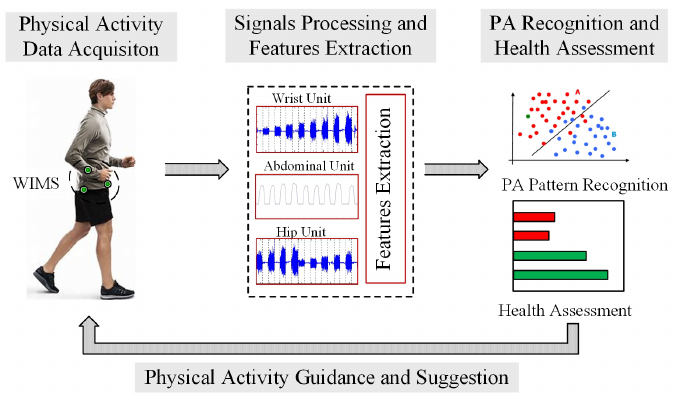
Figure 2. The overall architecture of the multi-sensor activity monitoring